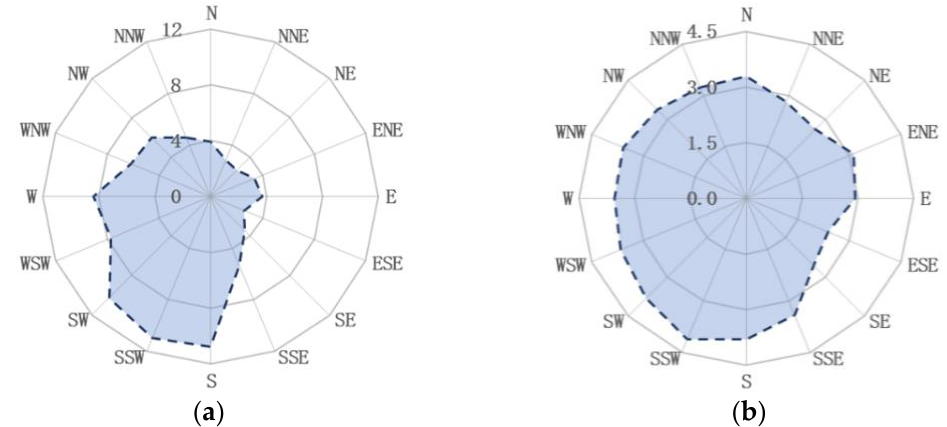
Figure 4. Harbin air velocity and frequency statistics map showing ( a ) air velocity statistics and ( b ) wind frequency statistics.